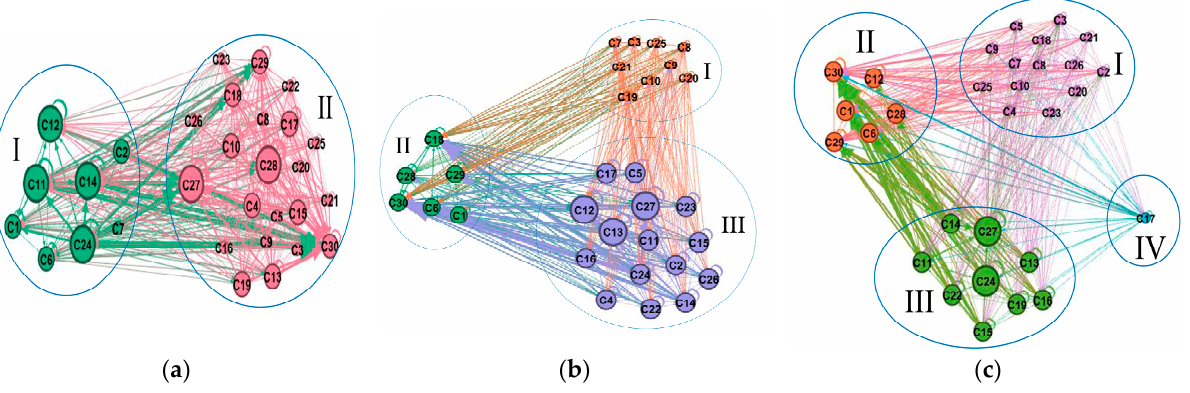
Figure 10. Coalescent subgroups of the ECETNs in Hei-Ji-Liao. ( a ) Coalescent subgroups for ECETN in Liaoning; ( b ) Coalescent subgroups for ECETN in Jilin; ( c ) Coalescent subgroups for ECETN in Heilongjiang.